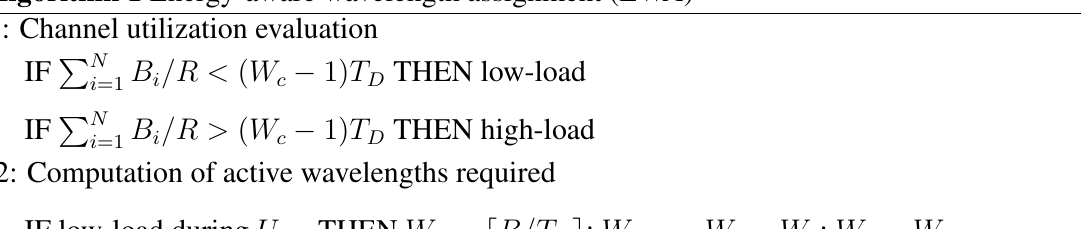
Algorithm 1 Energy-aware wavelength assignment